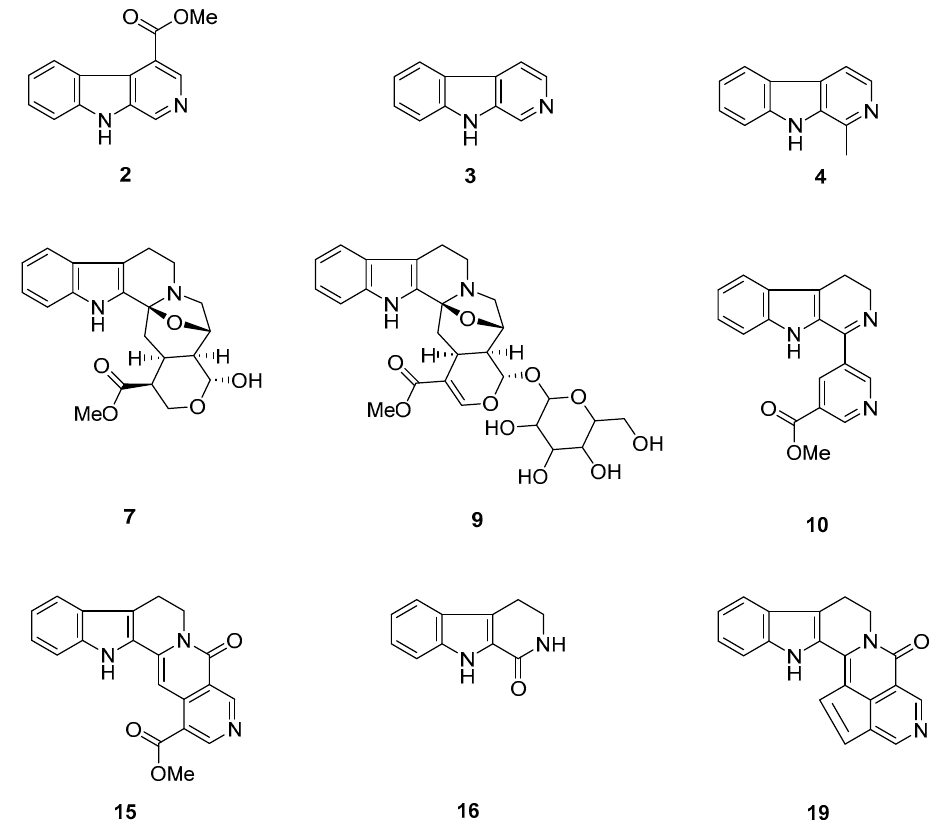
Figure 3. Compounds isolated from F5-F10: methyl 9H- β -carboline-4-carboxylate ( 2 ), norharmane ( 3 ), harmane ( 4 ), dihyrodeglycocadambine ( 7 ), cadambine ( 9 ), naucledine ( 10 ), neonaucline ( 15 ), 1,2,3,4-tetranorharmane-1-one ( 16 ), and naulafine ( 19 ). Dihydrodeglycocadambine 7 was obtained as an optically active, light yellow, and amorphous solid [ α ] 25 D = +57.3 ( c = 0.0004, MeOH), UV(MeOH) λ max (log ε ) 222 (4.18), 274 (3.64) nm. It has the molecular formula C 21 H 23 N 2 O 5 as deduced from the